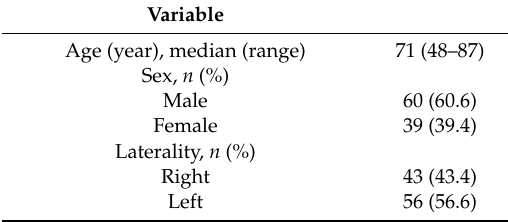
Table 1. Clinicopathologic characteristics and outcome of patients with upper tract urothelial carcinoma